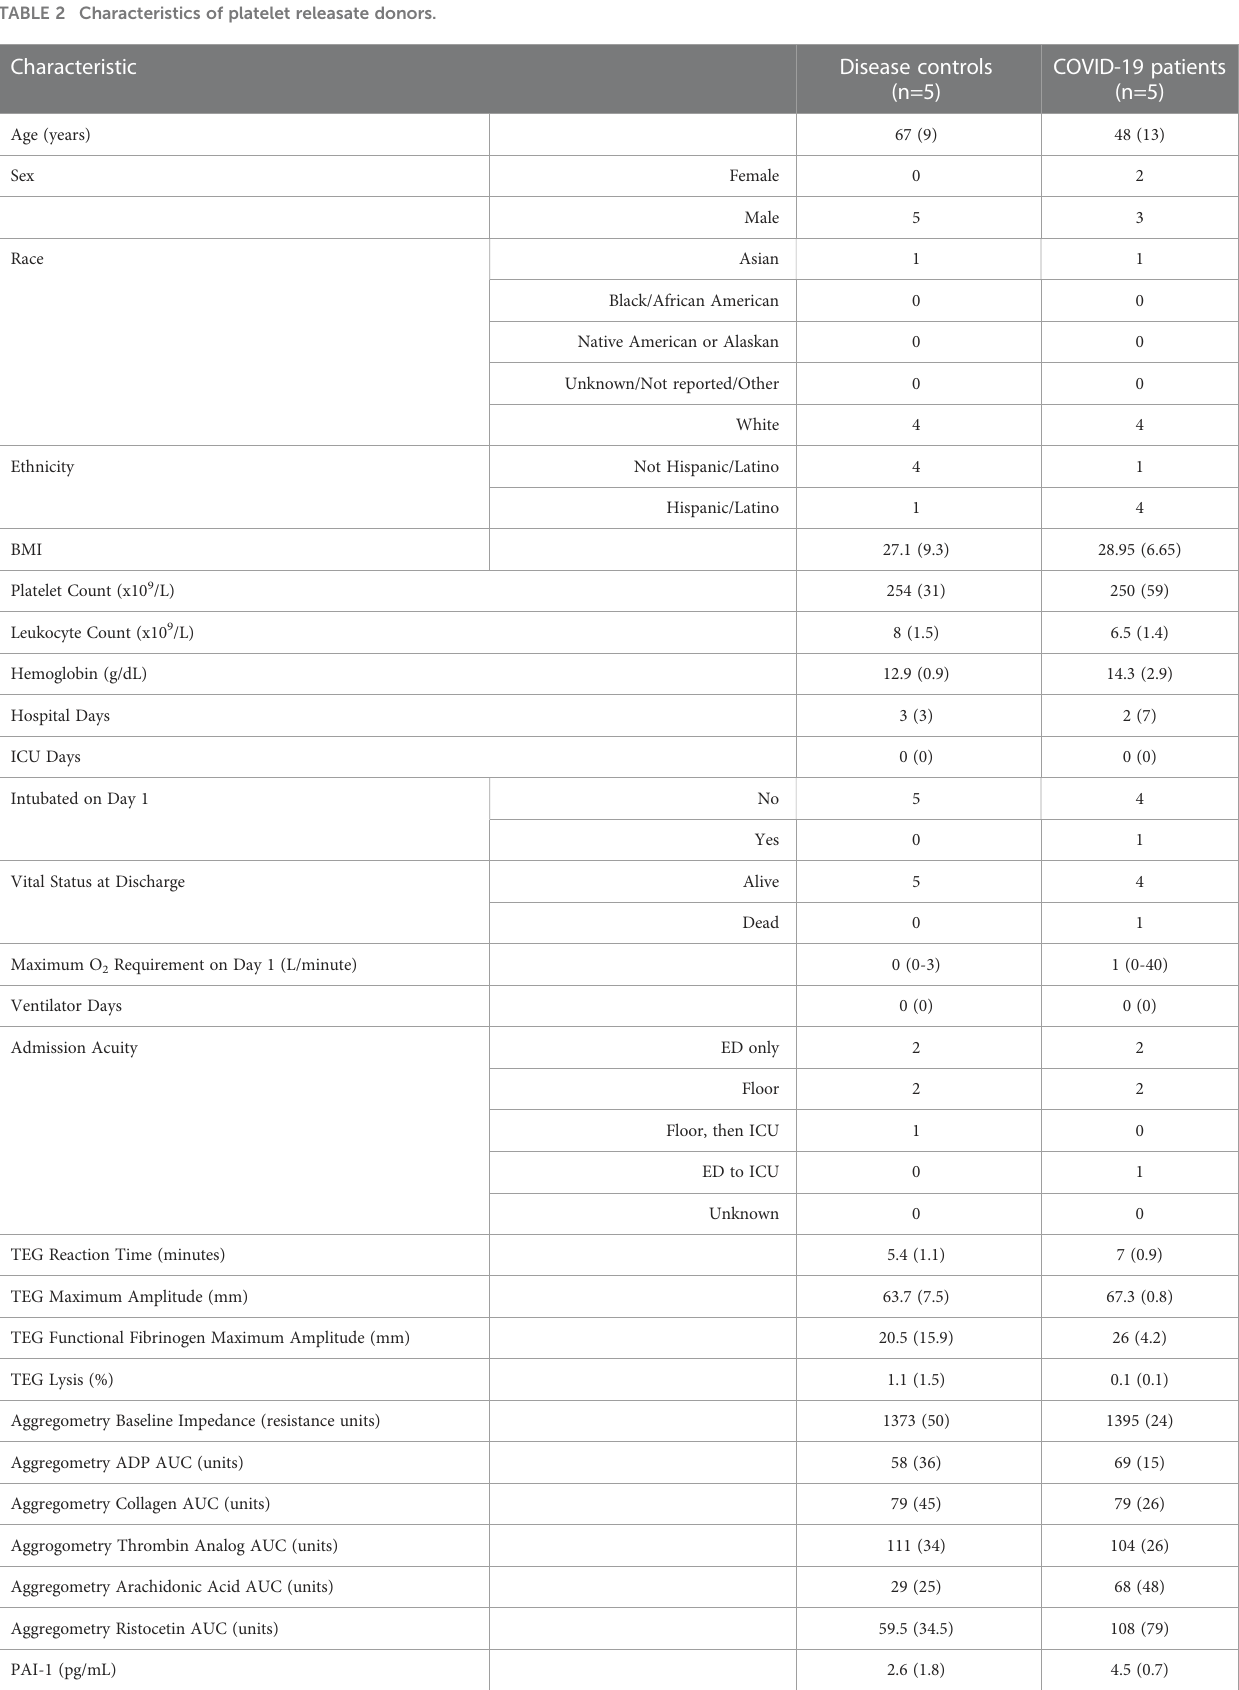
TABLE 2 Characteristics of platelet releasate